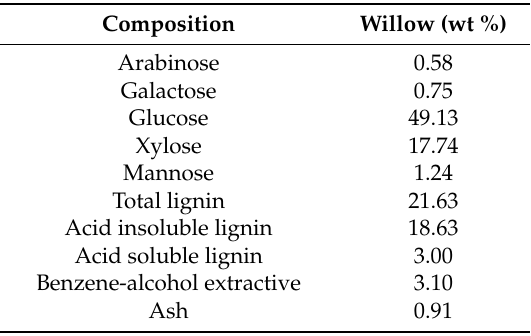
Table 6. Composition analysis of